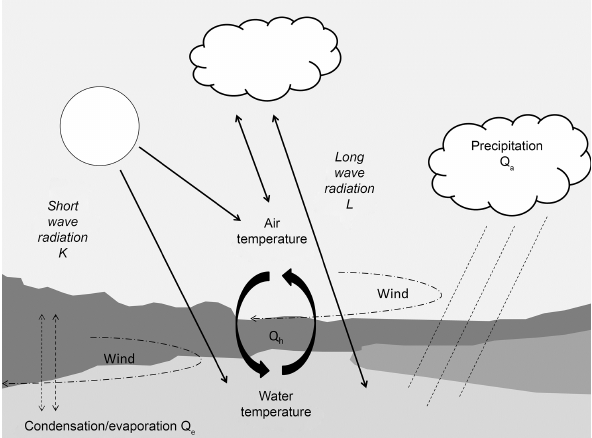
Figure 1. Multiple interdependent climate controls of water tem- perature; the sum of K and L corresponds to Q ∗ (heat flux due to net radiation); Q a corresponds to advective heat exchanges, which include precipitation (direct climatic component) and smaller fluxes due to inflow/outflow into river, hyporheic exchange, or groundwa- ter (not shown on figure); (adapted from Caissie, 2006, and Hannah et al.,